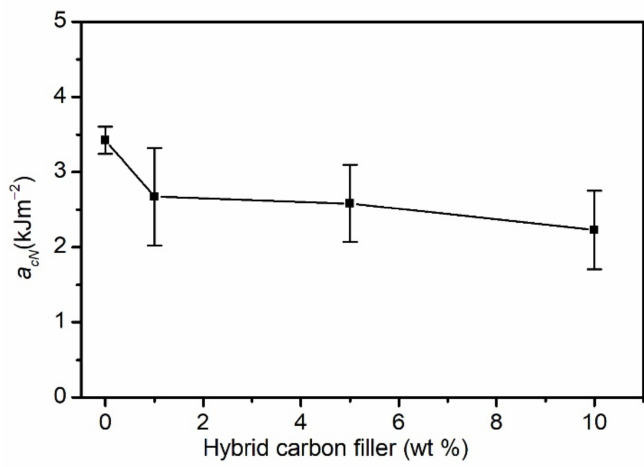
Figure 4. Impact strength of PVC CF/CNT–PVAc